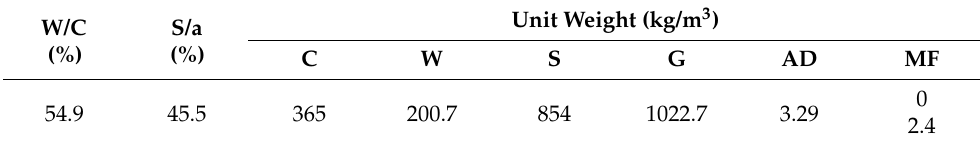
Table 3. Mix proportions of the